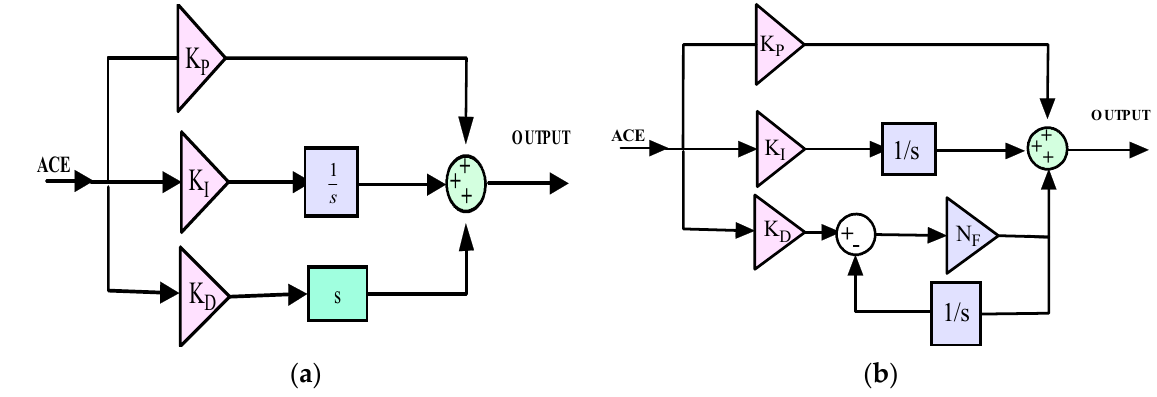
Figure 5. ( a ) Conventional PID Controller; ( b ) PID controller with filter (PIDN).